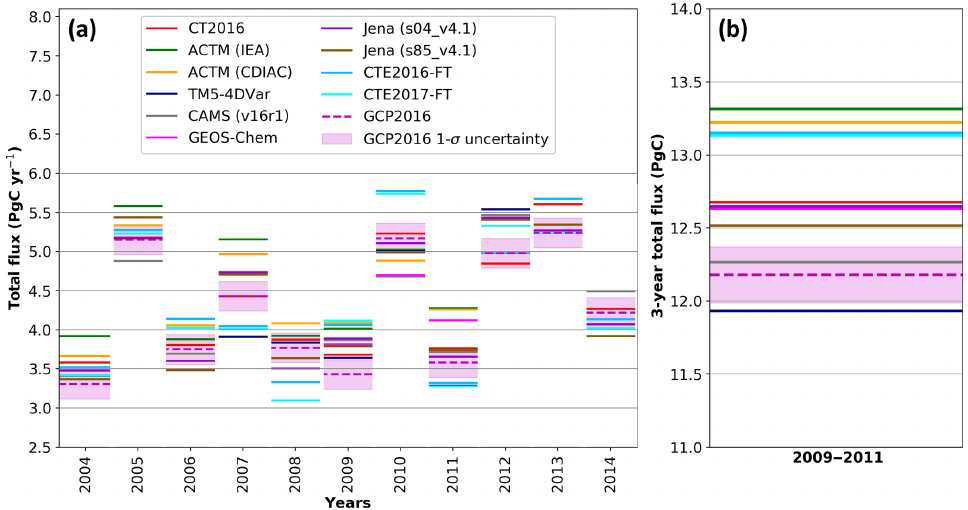
Figure 5. Modeled total flux (lines), equal to whole-atmosphere growth rate, that is the difference between the global FF emissions and the land and ocean fluxes. Atmospheric growth rate from GCP2016, derived from atmospheric CO 2 measurements made in the marine boundary layer by the NOAA ESRL flask network (Masarie and Tans, 1995; Dlugokencky and Tans, 2018) and GCP2016 assigned uncertainty (pink bands). (b) Shows the sum of the total flux for the 3 years (2009 to 2011).